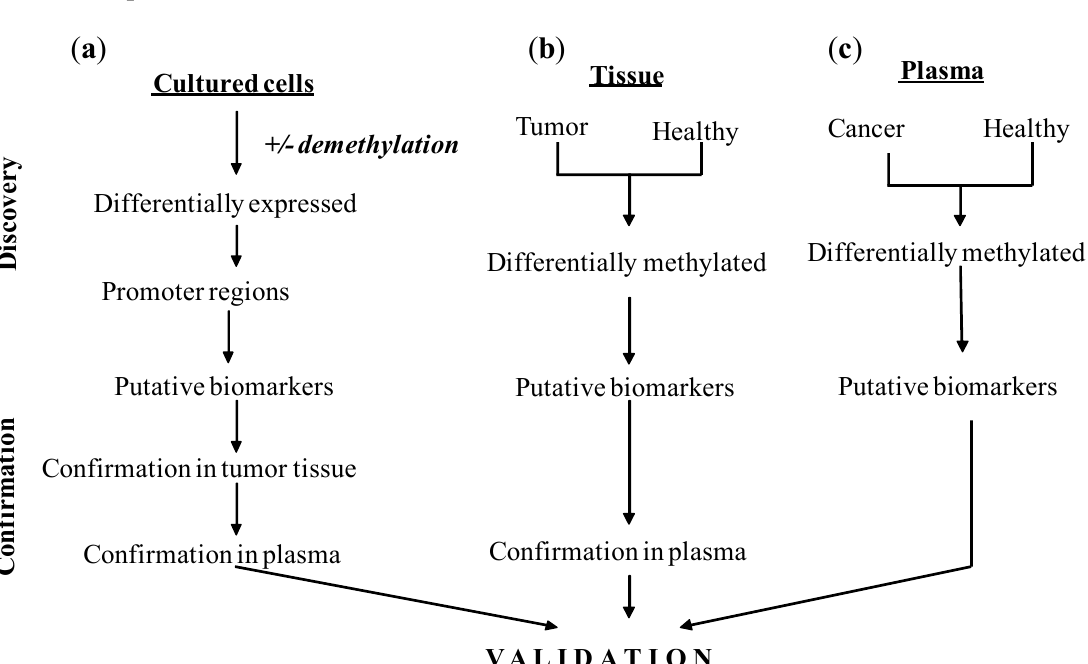
Figure 1. Different approaches for discovery of biomarkers based on genome-wide assessment. ( a ) Genome-wide expression patterns in cultured cells are compared, and a set of differentially expressed genes is identified. Promoters of these genes are then tested for abnormal methylation, and a group of putative biomarkers is selected for tissue analysis. Promoters confirmed in tissues are then investigated in cfcDNA. ( b ) Genome-wide methylation patterns in cancer tissue are compared to patterns in healthy tissue, and differentially methylated fragments are selected as putative biomarkers. These fragments are tested in cfcDNA. ( c ) Genome-wide patterns of methylation are compared using cfcDNA from cancer patients and healthy controls. Differentially methylated fragments are selected as putative